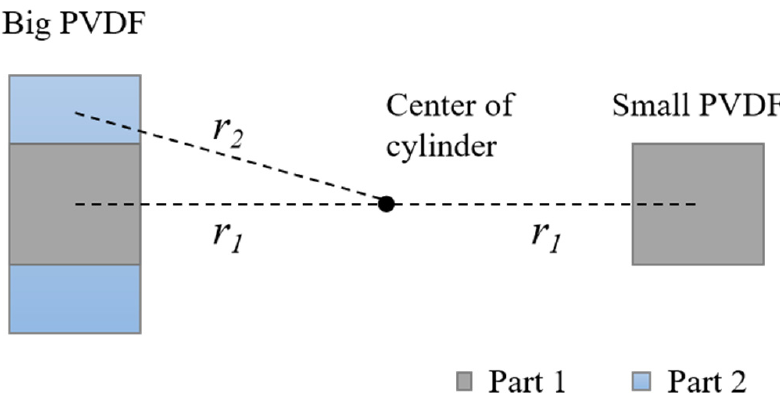
Figure 9. The internal stress field of the PVDF layer in the three directions computed by the FE model. This stress distribution can also explain the second phenomenon. The large PVDF element can be divided into two parts (see Figure 10). Part 1 has the same area to the small PVDF element which also has identical averaged volume stress as the small PVDF. Part 2 has two extra areas at both ends of Part 1. Compared with Part 1, it is farther from the center of the cylinder (r 2 > r 1 ) so that the average volume stress applied on Part 2 is less than that on Part 1. As a result, the overall averaged volume stress of the big PVDF element, which is the mean stress of these two parts, is less than the averaged volume stress of the small PVDF element. For clarity, the averaged volume stresses of PVDF elements computed by the FE model are given in Table 3. As can be seen, for each group, the averaged volume stresses of the big elements are smaller, which results in a smaller output.